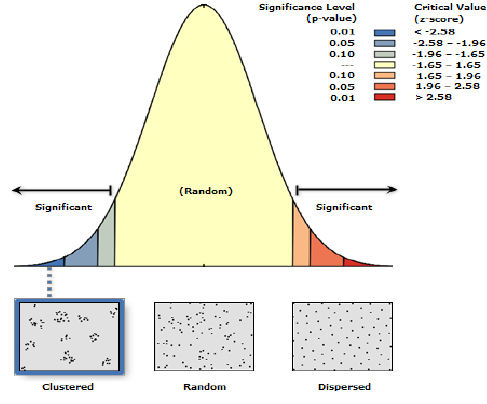
Figure 7: Average Nearest Neighbor for Lassa